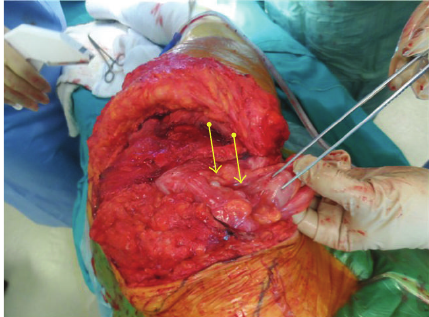
Figure 4: The intraoperative photograph, note the chondrosarcoma nodes in mesocolon (yellow arrows).